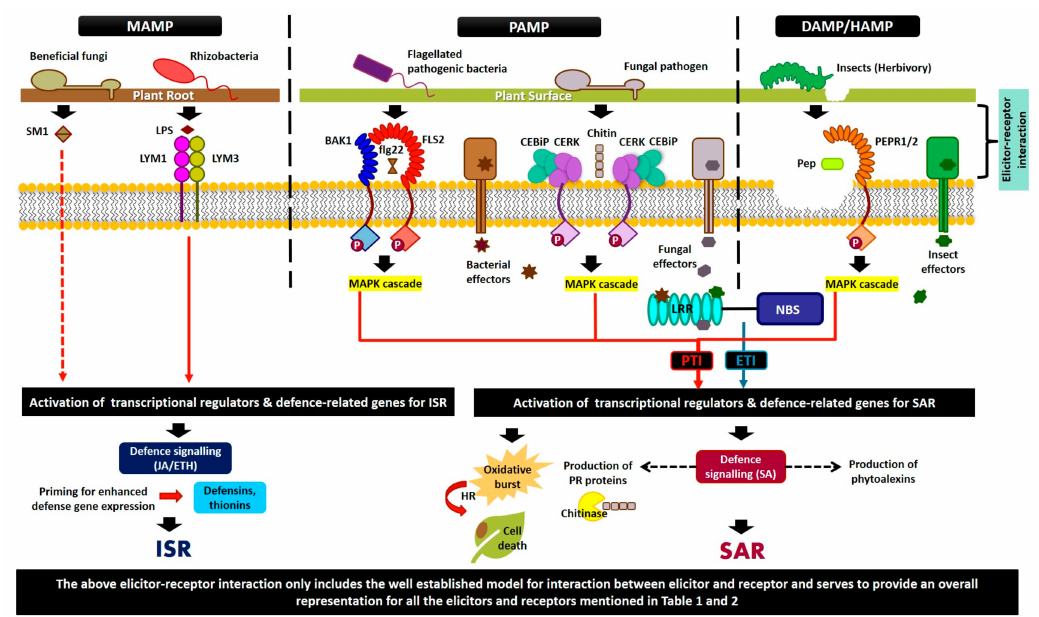
Figure 1. Pathogen-associated molecular patterns (PAMP)-triggered immunity (PTI) and e ff ector-triggered immunity (ETI) for di ff erent types of molecular patterns produced by pathogenic and non-pathogenic microorganisms and insects (microbe-associated molecular patterns (MAMPs), damage-associatedmolecularpatterns(DAMPs), andherbivore-associatedmolecularpatterns(HAMPs). The well-established elicitor–receptor model for pathogenic fungus and bacteria, insects and non-pathogenic microbes are chitin elicitor binding protein / chitin elicitor receptor kinase (CEBIP / CERK), chitin, FLAGELLINSENSITIVE2 / BRI1-associatedkinase(FLS2 / BAK1), flg22, PEPreceptor1 / 2(PEPR1 / 2), peptides (Pep), Lysin motif protein 1 (LYM1 / LYM2), LPS, and hydrophobin-like elicitor (SM1). Other 2 examples of elicitors and receptors are provided in Tables 1 and